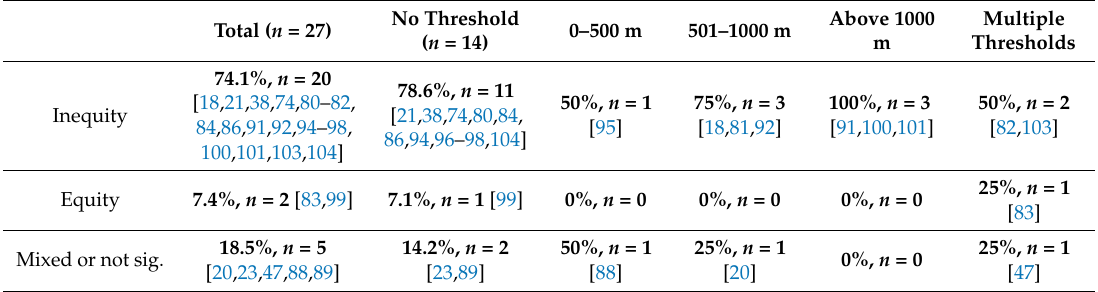
Table 4. Findings for green space proximity, organized by distance thresholds with article citations.